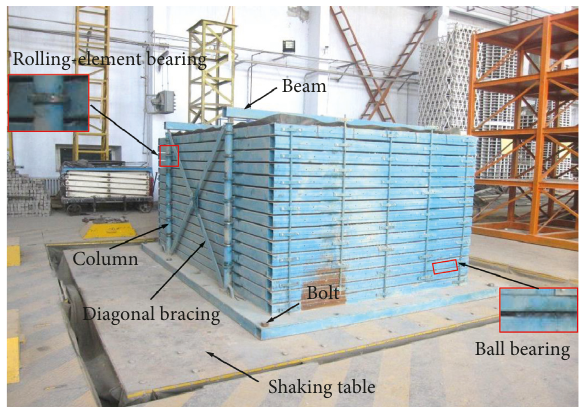
Figure 3: Laminate shear model